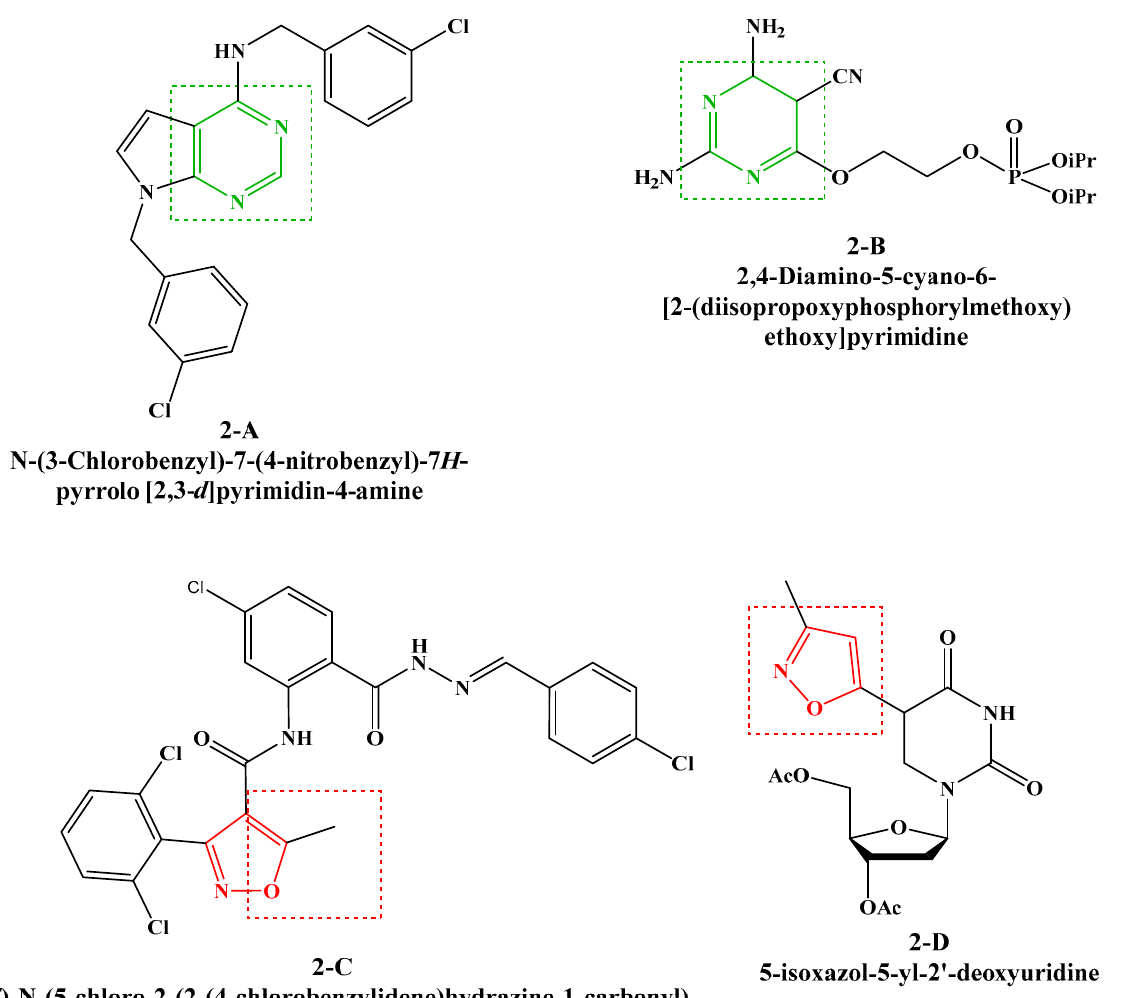
Figure 2. Previously reported antiviral compounds bearing pyrimidine and isoxazole rings.